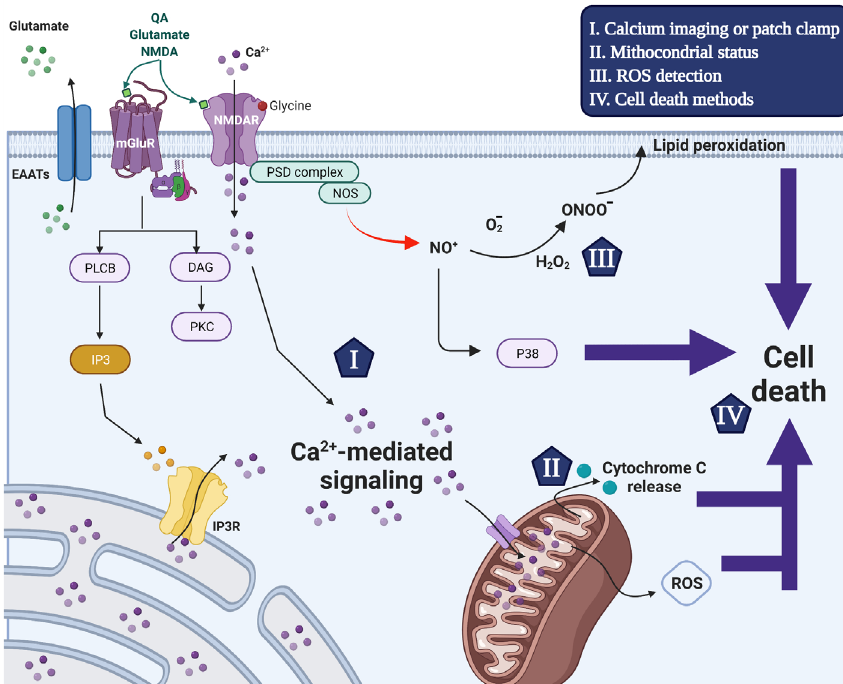
Figure 4. Schematic representation of the excitotoxicity mechanism that triggers neuronal cell death and used detection methods. Glutamate receptor agonists trigger intracellular [Ca 2+ ] increase through ionotropic and metabotropic glutamate receptor activation. i The activation of NMDAR by NMDA, glutamate or QA and the co-activator glycine increases the plasma membrane permeability to Ca 2+ ions. Alternatively, glutamate also induces transient [Ca 2+ ] increases through activation of G protein-coupled metabotropic i receptors activating phospholipase C-β to cleave PIP into IP and DAG. In turn, IP triggers the release of ER-mobilizated 2 3 3 intracellular Ca 2+ ions through the IP receptor. The Ca 2+ signaling is an important second messenger and disruption of its 3 homeostasis is related to the excitotoxicity process in excitatory neurons. Following [Ca 2+ ] increase, MCU transports Ca 2+ ions i to the mitochondrial matrix (Ca 2+ buffering) in a gradient favorable manner, which in turn disrupts mitochondrial membrane potential interrupting ATP production and initiating cell death mechanism. Moreover, The NMDAR interacts with nNOS in a PSD-95-dependent manner, and upon overstimulation the formation of nitric oxide, ROS and peroxynitrites that also contribute to cell death induction. The current accurate methods to evaluate excitotoxicity process are highlighted by items I-IV that are reviewed within the manuscript. EAATs: excitatory amino acid transporters; PLCB: phospholipase β; PKC: protein